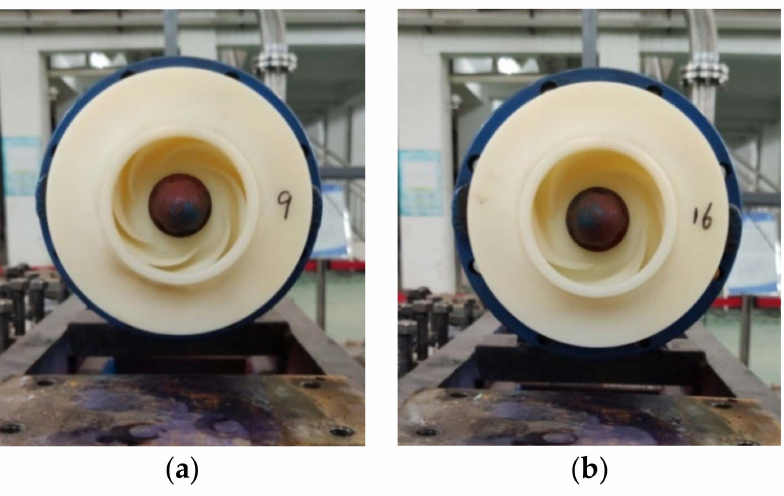
Figure 16. Rapid prototyping impellers of ( a ) scheme 9 and ( b ) scheme 16. Table 12. Tested performances of scheme 9 pump and scheme 16 pump under the condition of 25 m 3 /h.